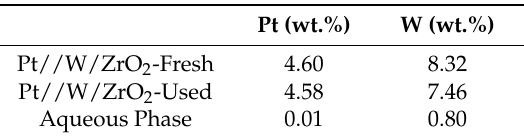
Figure 11. TGA-DTA-DTG analysis for spent Pt//W/ZrO 2 catalyst. Table 3. ICP-MS data obtained during the reusability test for Pt//W/ZrO 2 -200 in glycerol hydrogenolysis. Comparison between Pt and W content (weight, %) in fresh and first run recovered catalyst (used) and metal lixiviated to the reaction aqueous phase.